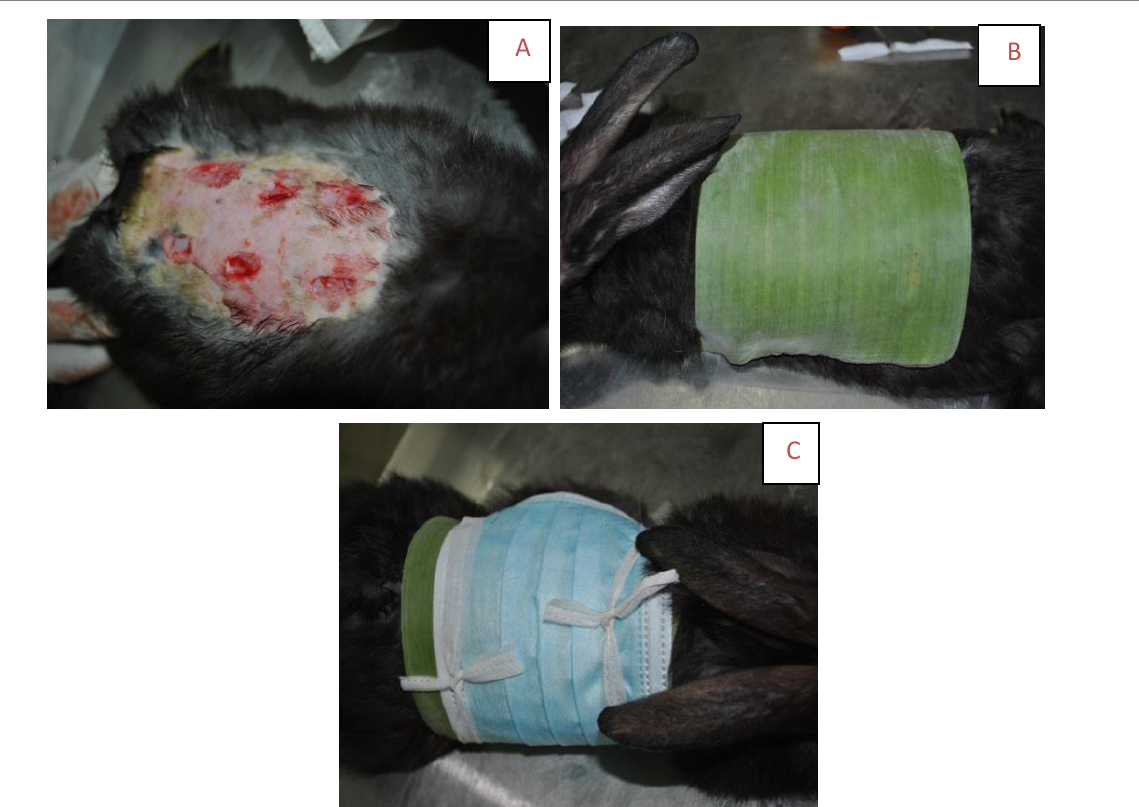
Figure, 1: Avulsion wounds were made on the back region (A), the wounds were covered by banana leaf (B) and fixation of banana leaf by bandage